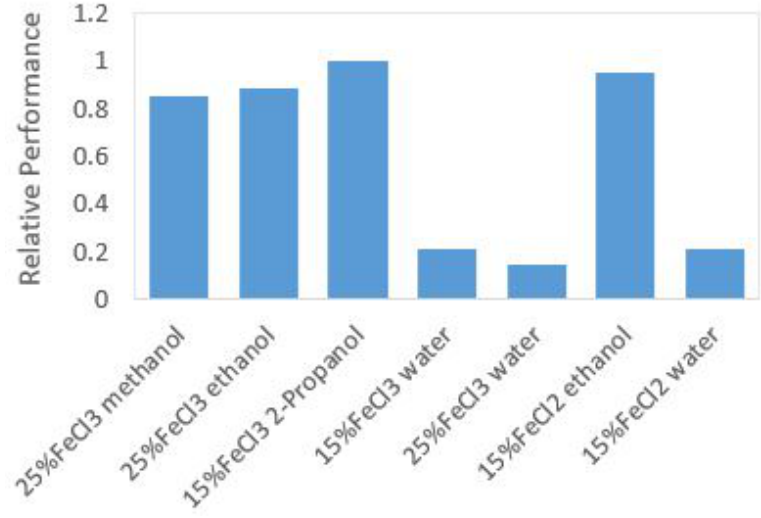
Figure 5. The relative expected performance of each solvent of interest based on three major performance and reliability characteristics including storage energy density, relative specific impulse, and solute